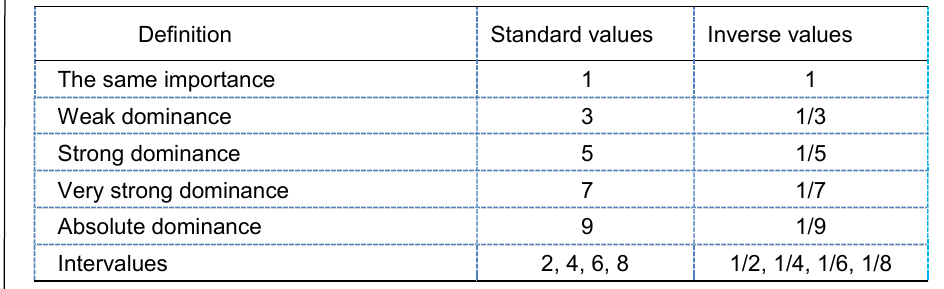
Table 1 – Saaty's scale for a comparison in pairs Таблица 1 – Шкала Саати для парного